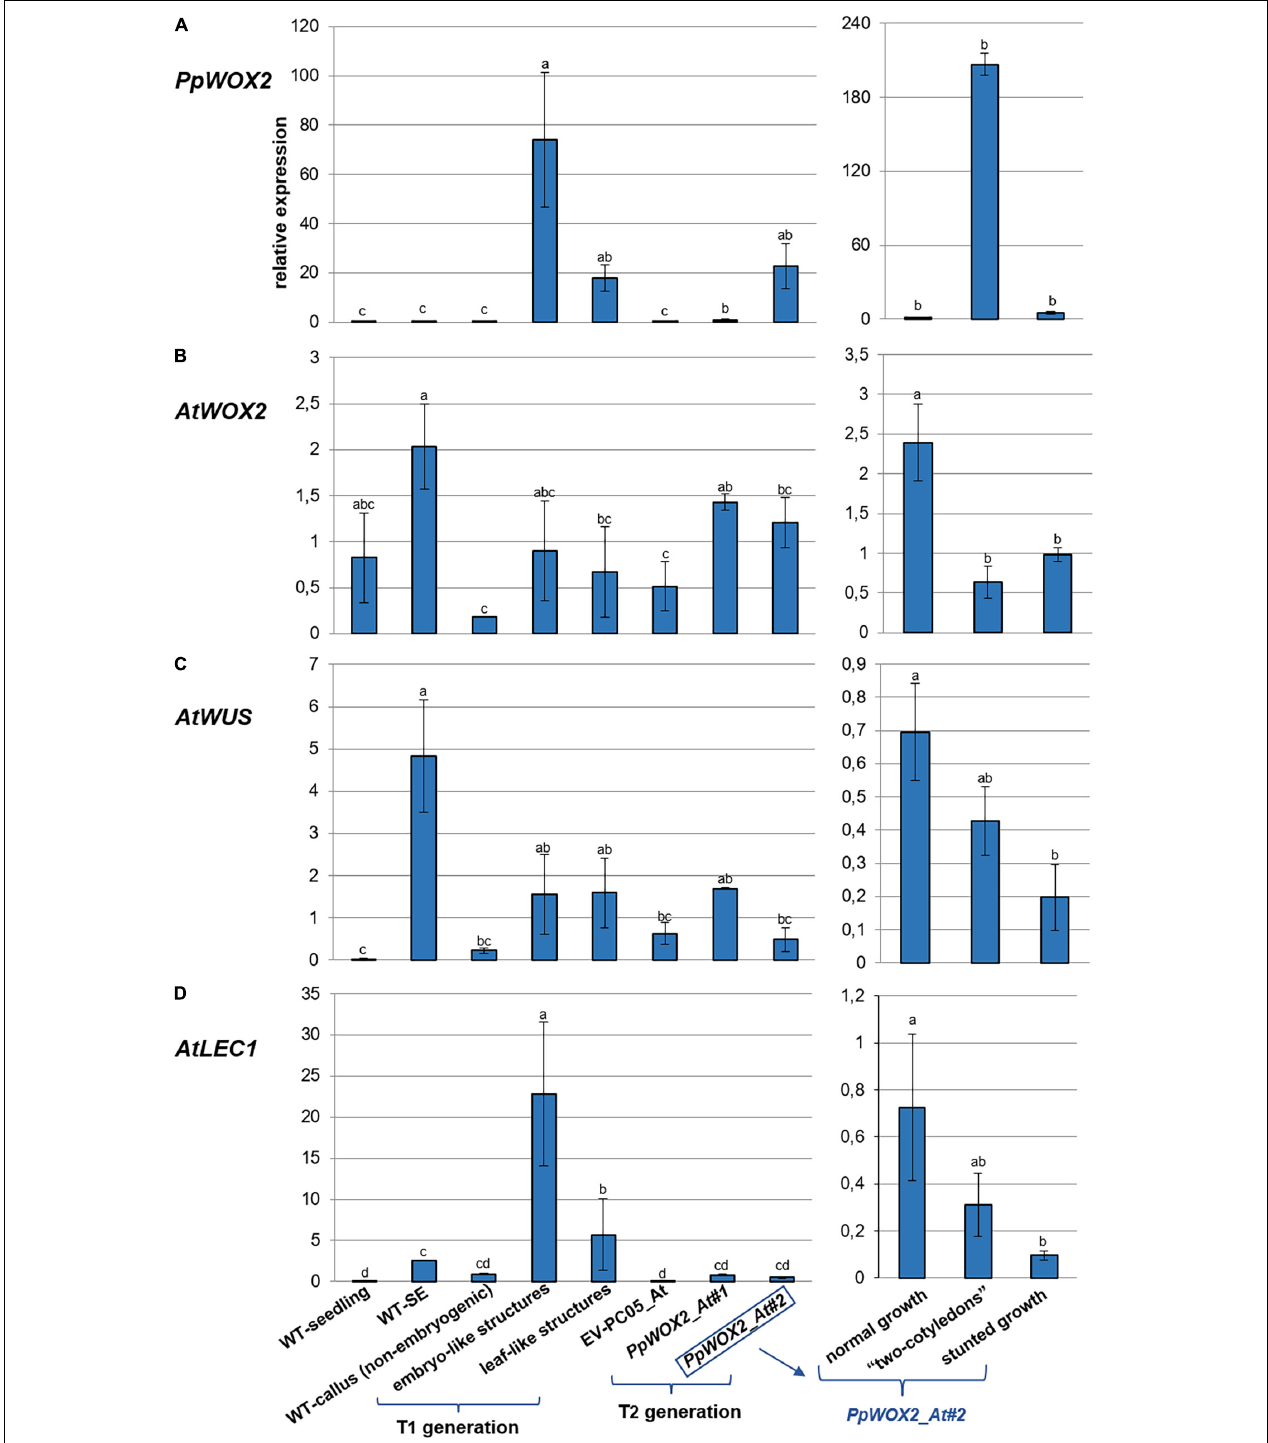
FIGURE 9 | Relative expression of (A) PpWOX2 , (B) AtWOX2 , (C) AtWUS , and (D) AtLEC1 in Arabidopsis plants obtained from PpWOX2 overexpressing lines (T 1 and T 2 generations), transgenic EV-pC05_At, and non-transgenic WT controls (seedlings and somatic embryos/SE) at the same age and developmental stage by RT-qPCR. Each value represents mean ± standard error of three biological replicates and three technical replicates. Bars with different letters indicate significant differences (ANOVA, P < 0.05). The different phenotypes are illustrated in Figure 8 . Samples PpWOX2_ At#1 and PpWOX2 _At#2 from the T 2 generation are a mixture of plants with the “normal,” “two-cotyledon,” and “stunted growth” phenotypes. Gene expression is presented separately for these three phenotypes for line PpWOX2_At#2 (right part of the